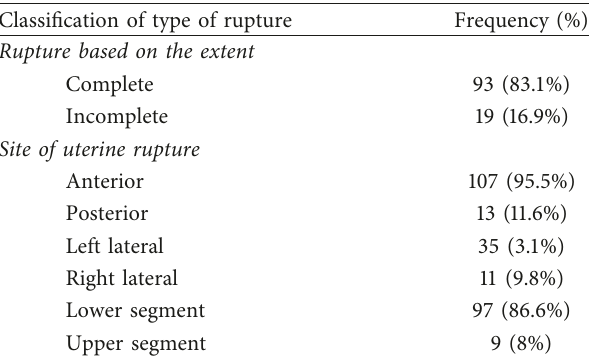
Table 2: Classification of cases of uterine rupture based on their type occurred at Suhul General Hospital, Shire Town, North West Tigray, Ethiopia,